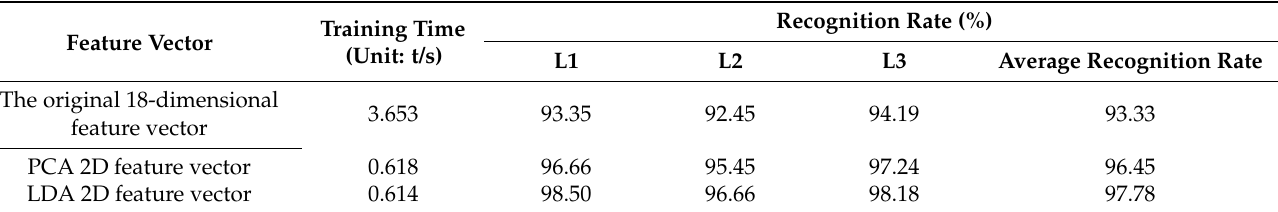
Figure 17. The grading results analyzed by PCA and LDA. ( a ) PCA, ( b ) LDA. Table 5. The influence of the feature vector with the result of